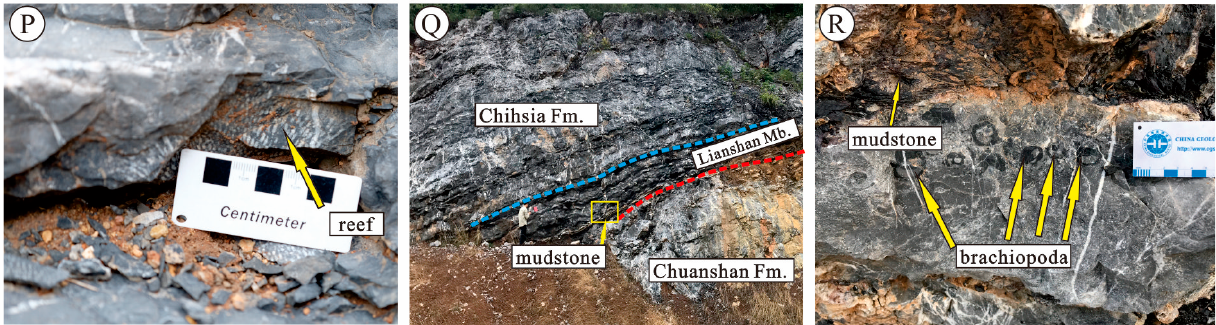
Figure 3. Typical rock types from the Putaoling section collected from the Lower Yangtze region. ( A ) A thin black layer of siliceous rock. ( B ) Siliceous rocks that contain abundant radiolarians and sponge spicules of different sizes. ( C ) Wackestones that contain abundant foraminifera. ( D ) Limestone intercalated with dark grey calcareous shale. ( E ) Calcareous shale. ( F ) Limestone with abundant black lenticular or nodular chert. ( G ) Foraminifera. ( H ) Bryozoan. ( I ) Abundant brachiopods can be seen in the bioclastic limestone. ( J ) Foraminifera. ( K ) Brachiopods. ( L ) Crinoids. ( M ) Medium-bedded wackestone. ( N ) Nodular chert. ( O ) Thick-bedded packstone, abundant bioclasts. ( P ) Corals. ( Q ) Limestone intercalated with a coal seam. ( R ) Abundant brachiopod fossils.